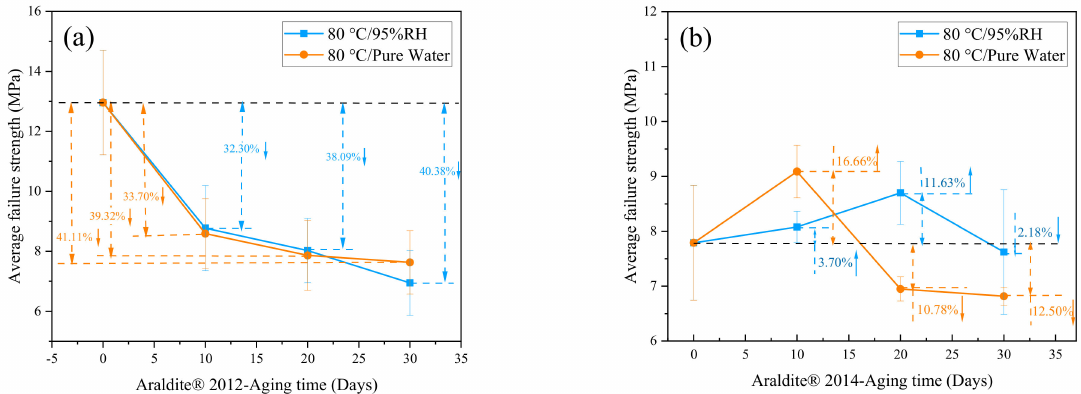
Figure 9. Failure strength of the adhesive joints in different environments: ( a ) Araldite® 2012 in 80 ◦ C/95%RH and 80 ◦ C/pure water, ( b ) Araldite® 2014 in 80 ◦ C/95%RH and 80 ◦ C/pure